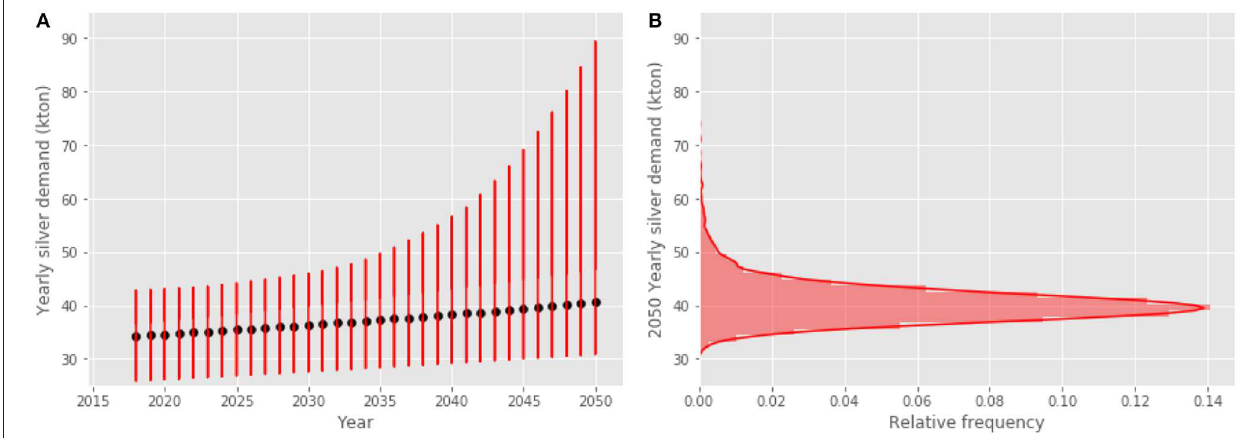
FIGURE 1 | (A) Yearly trend of silver demand (kiloton per year) over 2018–2050 according to the Monte Carlo simulations run on 8,192 quasi-random samples. The means of the yearly distributions are shown in black. (B) The distribution of the simulations outcome for the year 2050 (yearly silver demand against relative frequency).